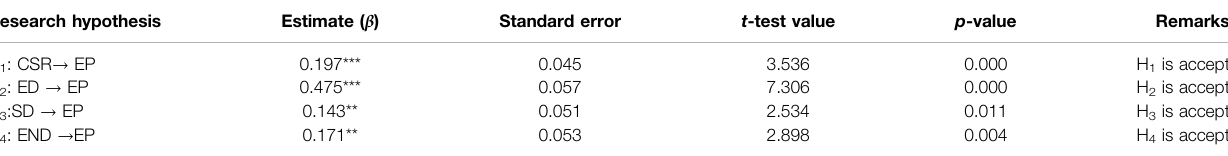
TABLE 5 | Test of research